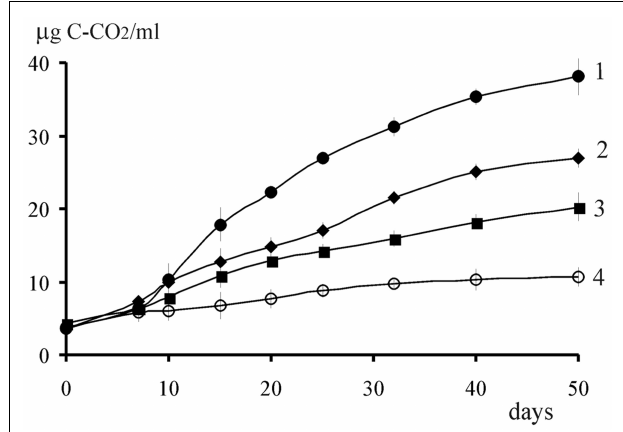
FIGURE 5 | Dynamics of CO 2 production in experimental flasks with carboxymethyl cellulose (1), fibrous cellulose (2), and microcrystalline cellulose (3) versus control incubations (4). The increase in CO 2 concentration in control flasks is due to the utilization of yeast extract used for medium preparation. Data are averages of three flasks ± 1 STDEV. Where error bars are not visible, they are contained within the symbol.